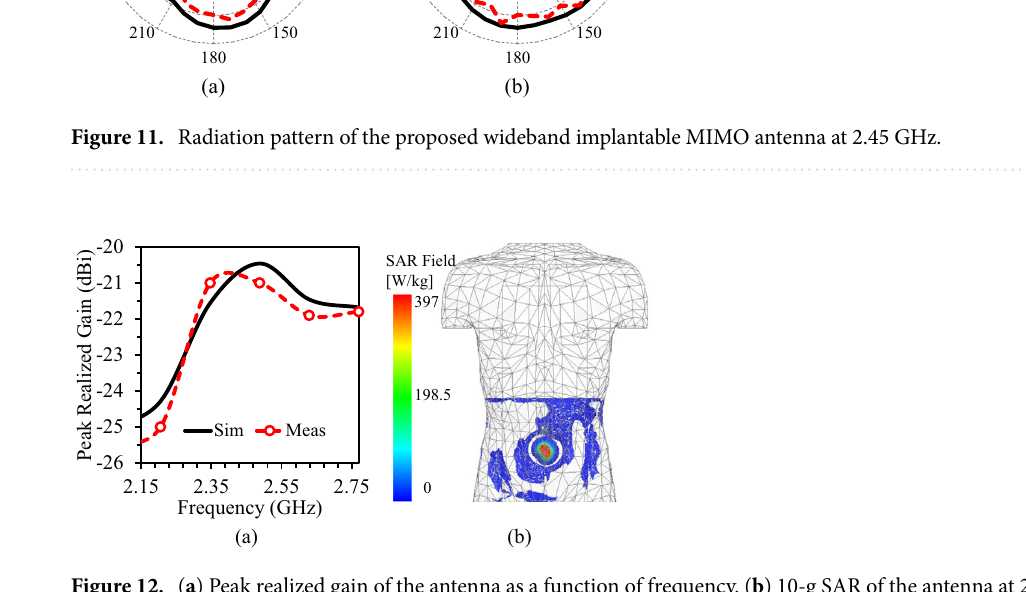
Figure 12. ( a ) Peak realized gain of the antenna as a function of frequency. ( b ) 10-g SAR of the antenna at 2.45 GHz 40